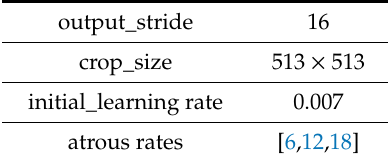
Table 3. Parameter settings of DeepLabv3 +